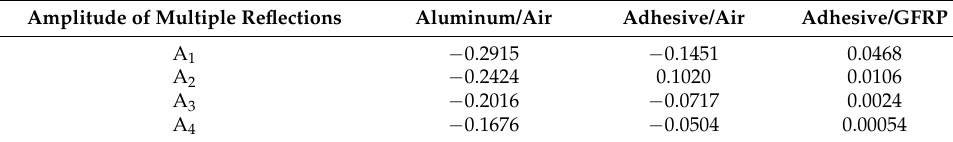
Table 3. Amplitudes of multiple reflections in each particular layer.